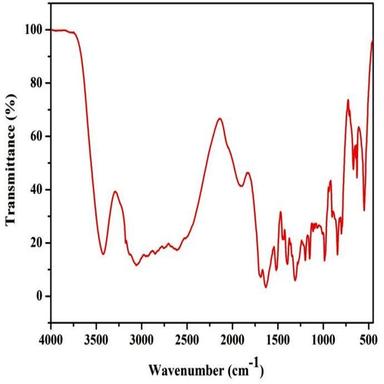
FTIR spectrum of LHFFAM.